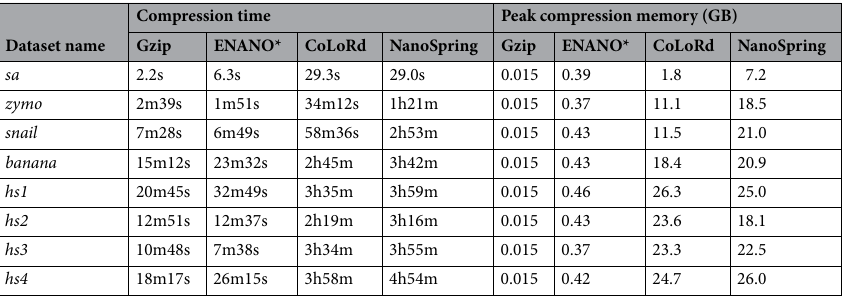
Table 3. Time and peak memory requirements for compression. *ENANO figures include the time/memory usage to compress the entire FASTQ file including read sequences, quality values and read identifiers.